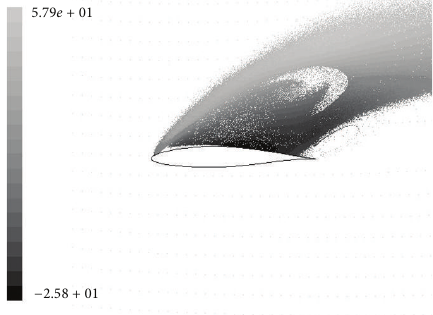
Figure 14: Raindrop traces at AOA = 4 degree.